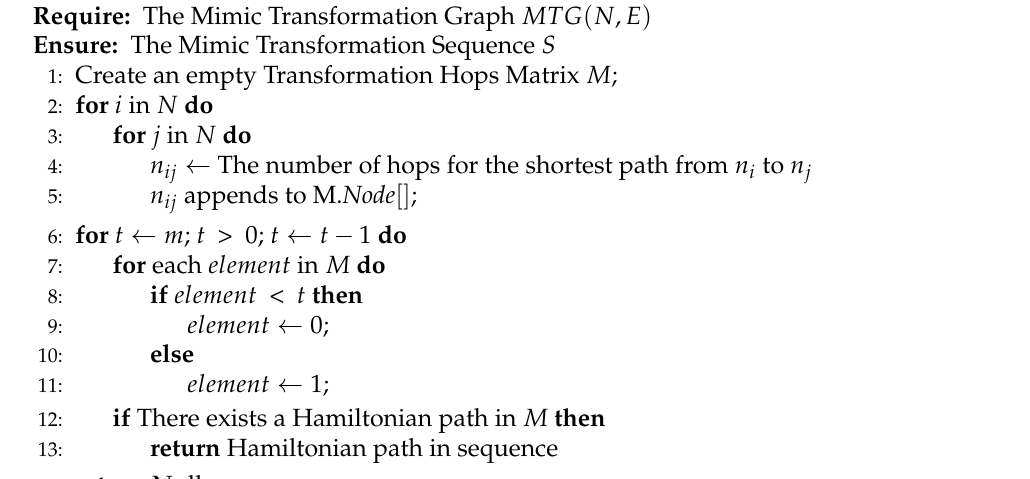
Algorithm 2 Generate the mimic transformation